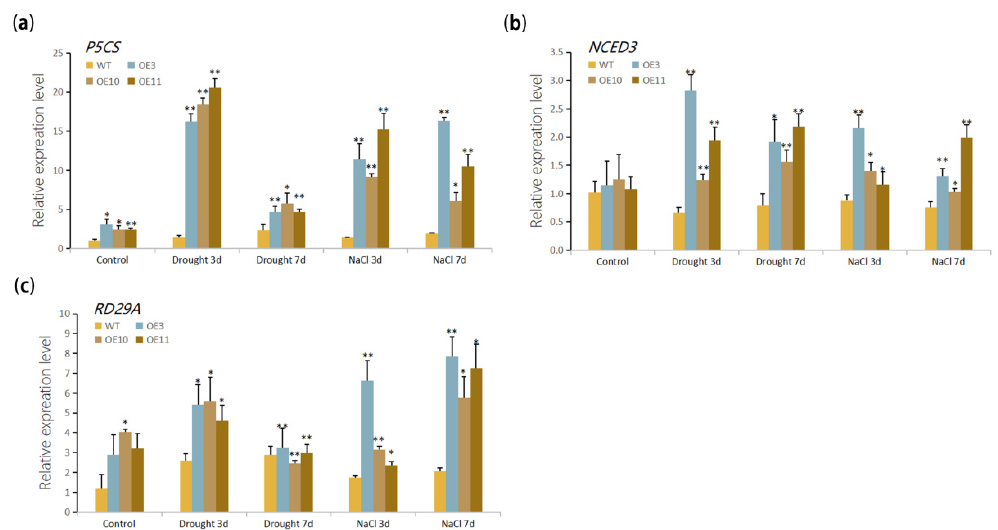
Figure 7. Expression levels of stress-responsive genes in MfWRKY70 transgenic Arabidopsis upon drought and salinity stress tolerance. Expression levels of P5CS ( a ), NCED3 ( b ), and RD29A ( c ) were measured by qRT-PCR in MfWRKY70 transgenic and WT Arabidopsis treated by 10% PEG-6000 or 300 mM NaCl. AtActin2 was used as an internal control. Data are presented as mean and SD values of three independent experiments. Asterisks indicate significant difference (* p < 0.05, ** p < 0.01, by Student’s t -test) comparing to